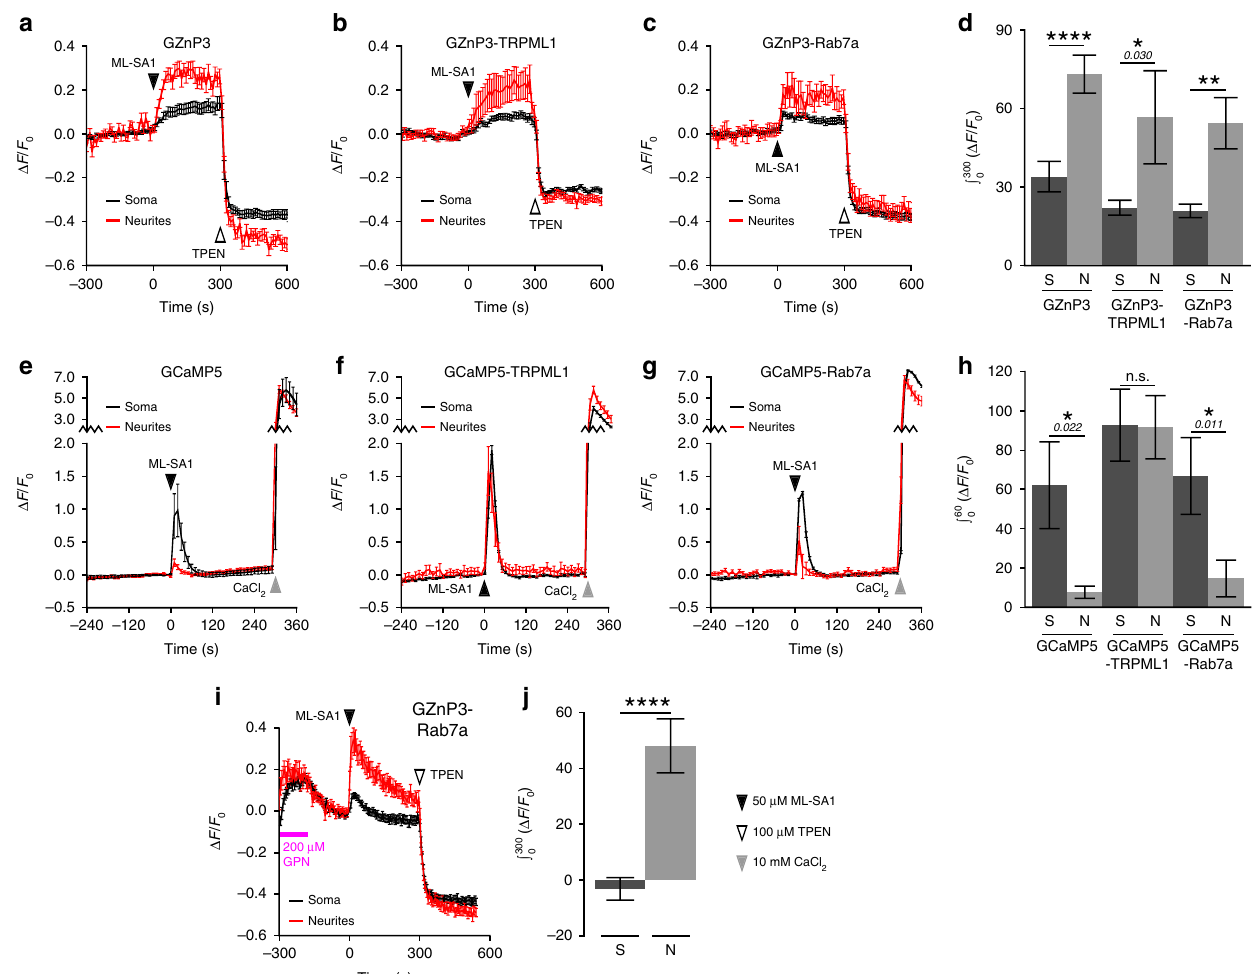
Fig. 6 TRPML1 mediates greater Zn 2 + release and less Ca 2 + release in neurites than in the soma. Average traces (±s.e.m.) from soma (black) or neurites (red) of primary rat hippocampal neurons co-expressing a mCherry-TRPML1 and GZnP3, b expressing GZnP3-TRPML1, or c co-expressing mCherry- TRPML1 and GZnP3-Rab7a. d Mean integrated GZnP3 signal (±s.e.m.) 300 s after ML-SA1 addition between soma (dark) and neurites (light) for GZnP3 (soma, n = 10; neurites, n = 70 puncta), GZnP3-TRPML1 (soma, n = 48 puncta; neurites, n = 54 puncta), and GZnP3-Rab7a (soma, n = 62 puncta; neurites, n = 28 puncta). One-tailed Student ’ s t -tests. Average traces (±s.e.m.) from soma (black) or neurites (red) of primary rat hippocampal